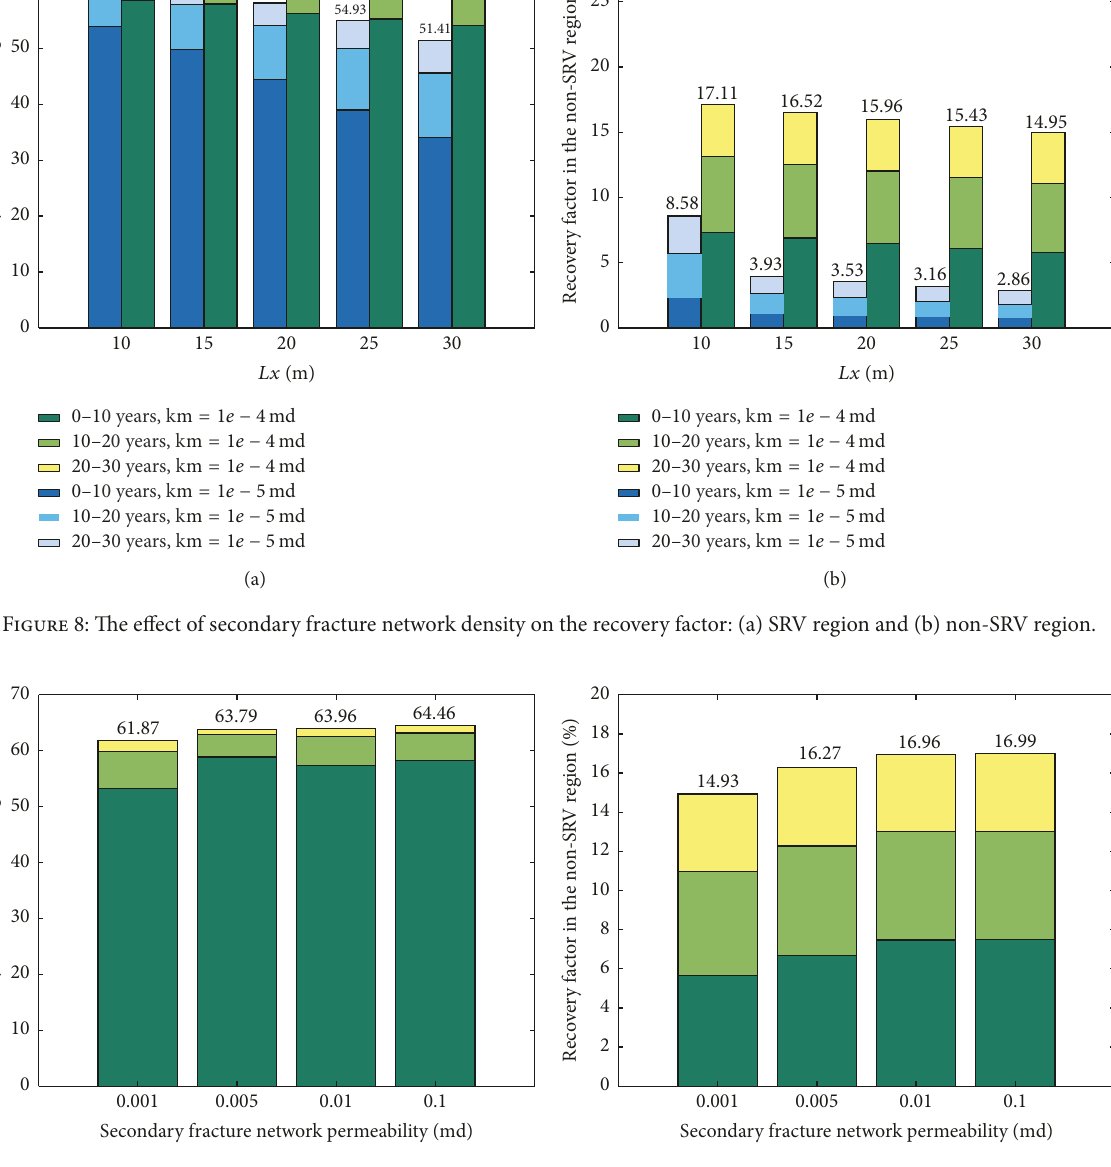
fracture half-length are selected, that is, 150 m, 130 m, and 110 m., and the corresponding OGIPs in SRV region are 2.25 × 10 9 m 3 , 1.95 × 10 9 m 3 , and 1.65 × 10 9 m 3 . Figure 14